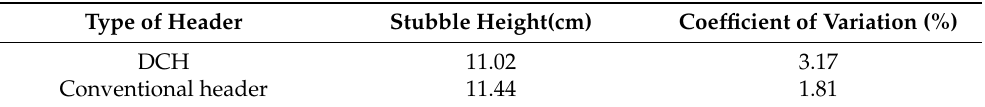
Figure 14. Harvesting loss rate of the WCH using different headers. Table 6. Measurement results of the stubble height.